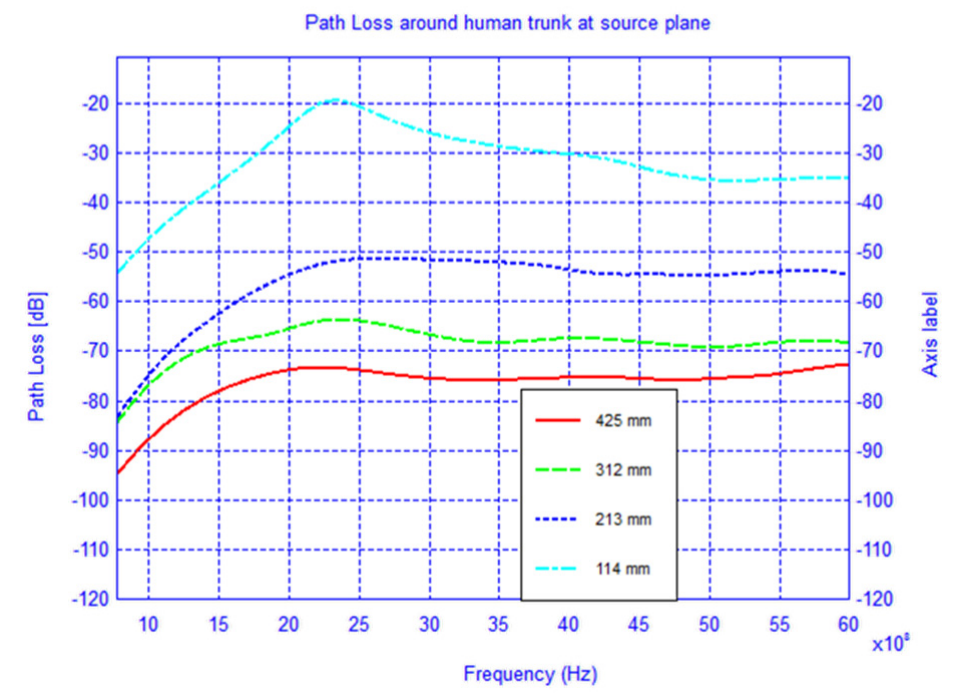
Figure 2. Path loss around the cylindrical human trunk model at the source